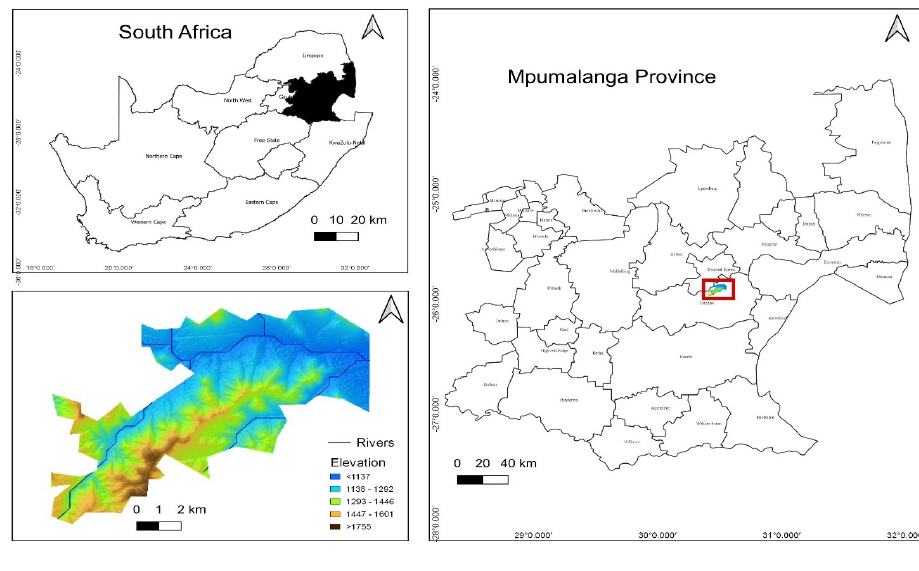
Figure 1. Location of the study area, Komati